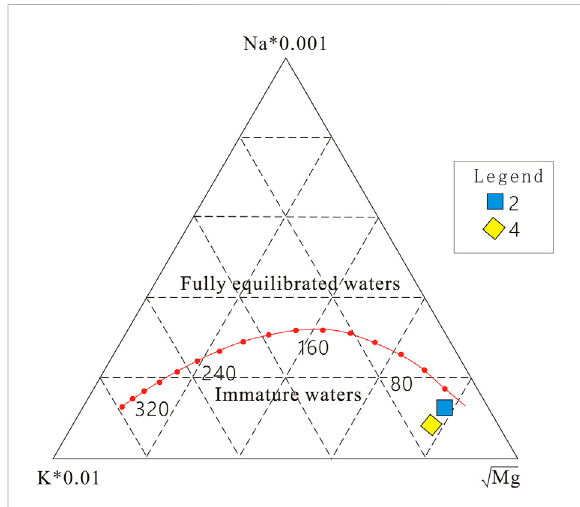
FIGURE 4 Na – K – Mg diagram of the Hongshuilantang Hot Spring. The numbers in the fi gure correspond to those in Table 1.